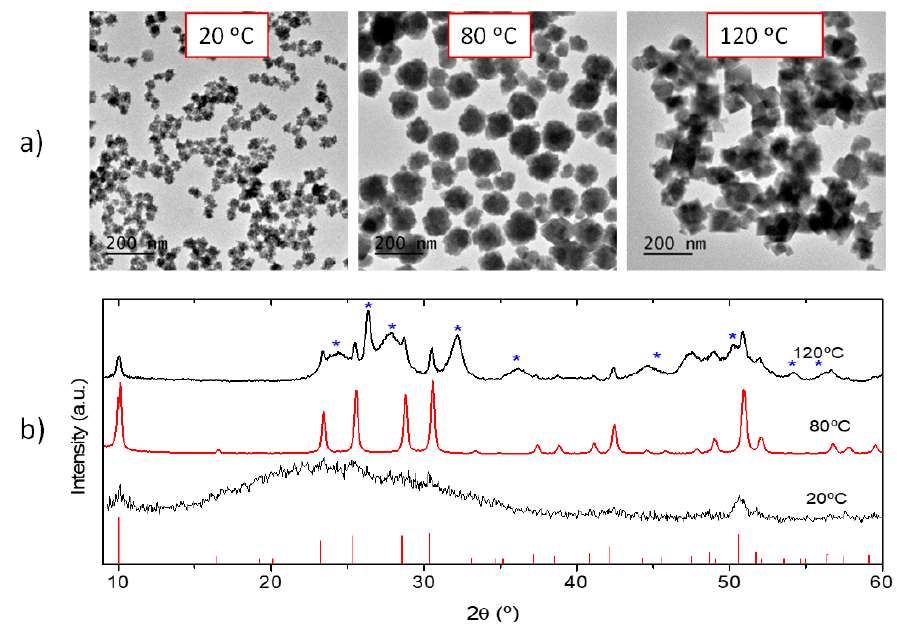
Figure 2. ( a ) TEM micrographs of nanoparticles obtained in the same conditions as described in Figure 1 except for the temperature, which was changed to the values shown in the labels. ( b ) Corresponding XRD patterns; ticks at the bottom correspond to cubic (H 3 O)Lu 3 F 10 (PDF 04-016-7065) while asterisks on the top plot correspond to orthorhombic LuF 3 (PDF 00-032-0612).